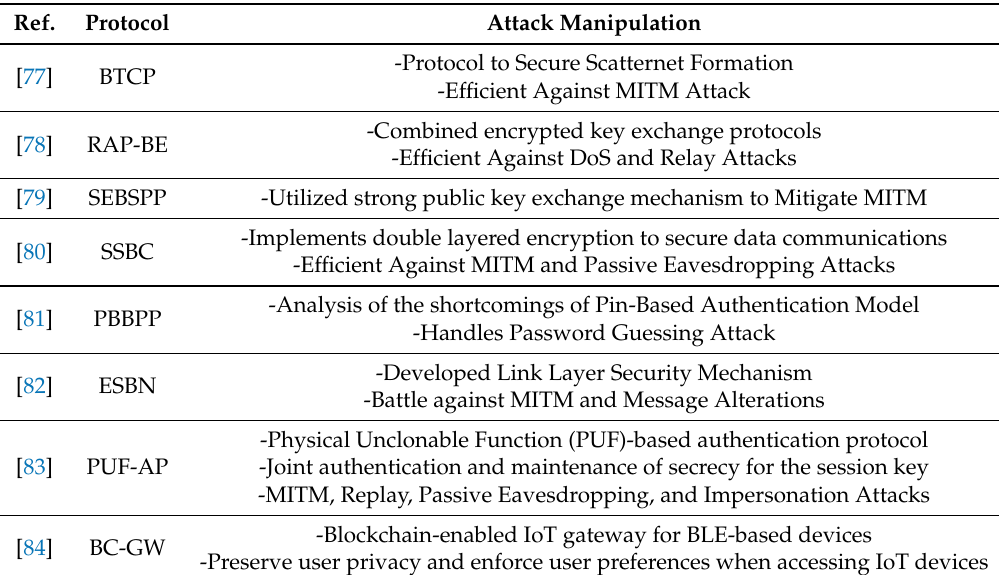
Table 2 is a summary of the Bluetooth security enhancements. Table 2. Enhancements for Bluetooth